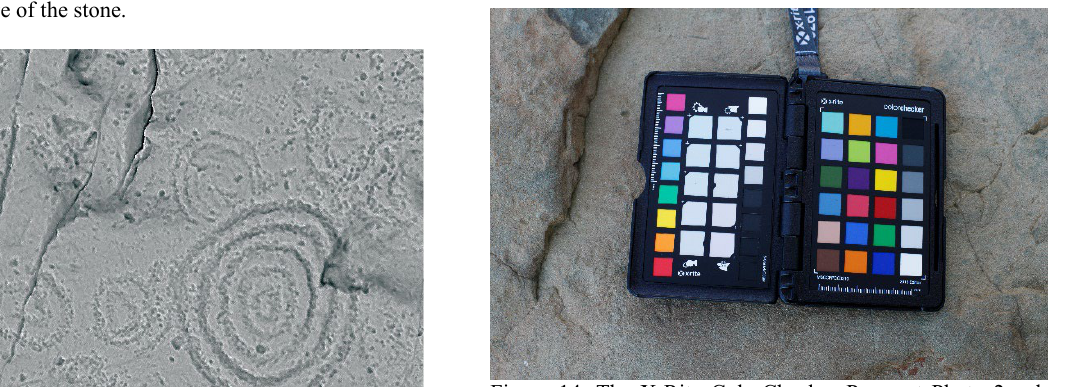
Figure 14. The X-Rite ColorChecker Passport Photo 2 colour calibration